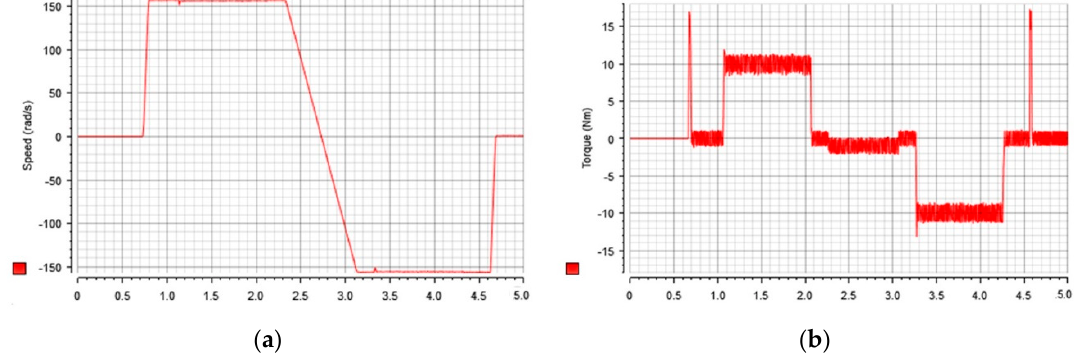
Figure 21. Speed ( a ) and torque ( b ) of the GA–DTC.